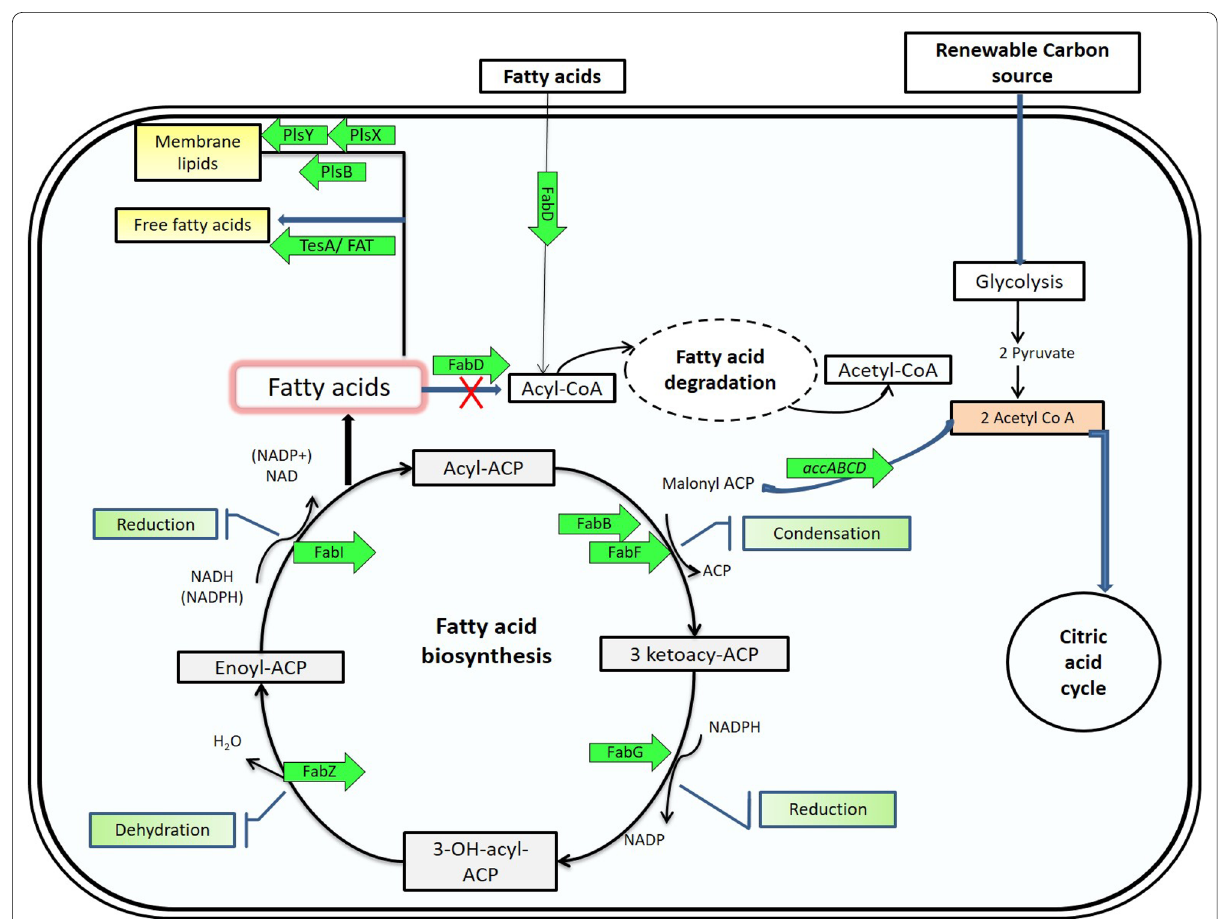
Fig. 3 Fatty acid synthesis and degradation in E.coli. Green arrow indicates gene that code for particular protein or enzyme required for the reaction. Red Cross indicate blocking particular pathway for inhibit fatty acid